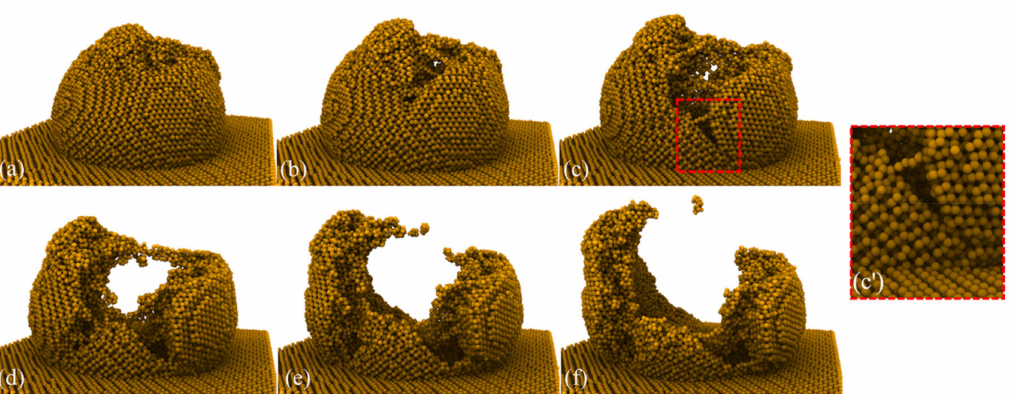
Figure 13. The rough GaAs morphology images show surface deformation accompanied by the formation and propagation of V-shaped cracks at the plowing distances of ( a ) 10 nm, ( b ) 11 nm, ( c , c’ ) 12 nm, ( d ) 13 nm, ( e ) 14 nm and ( f ) 15 nm in the case of the indenter diameter of 9